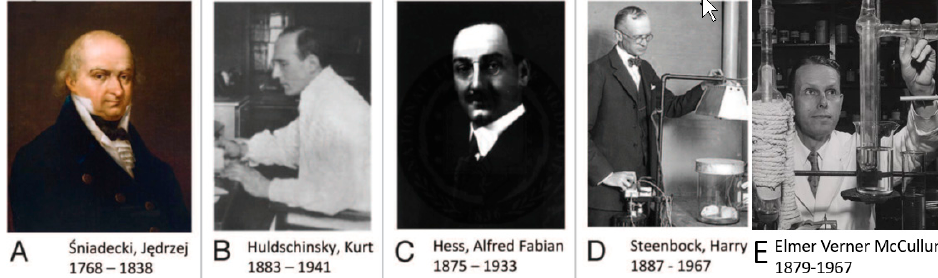
Figure 3. Photographs of researchers who made crucial contributions to vitamin D and rickets research. ( A ) J ę drzej Sniadecki, ( B ) Kurt Huldschinsky, ( C ) Alfred Hess, ( D ) Harry Steenbock, and ( E ) Elmer McCullum. Ref. [8] Holick, copyright 2013. Reproduced with permission.